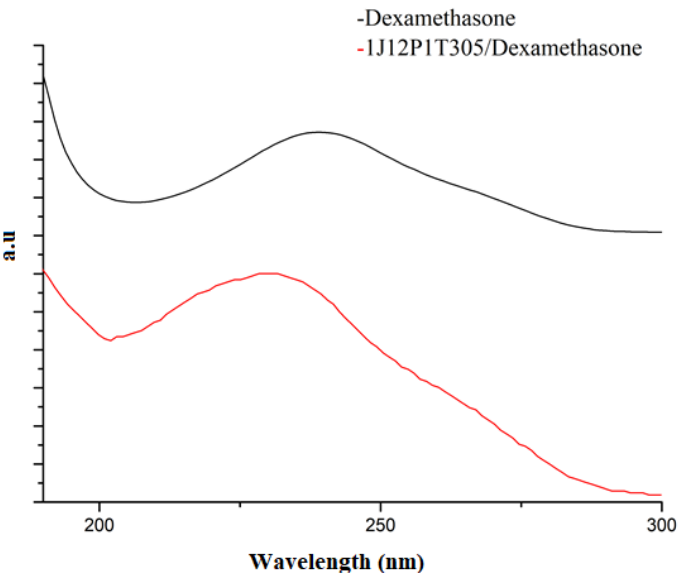
Figure 10. UV/Vis spectra of pure dexamethasone in ethanol ( black ) and dexamethasone loaded JFP/pullulan nanofibers (1J12P1T305) showing the existence ( red ) of dexamethasone in water.